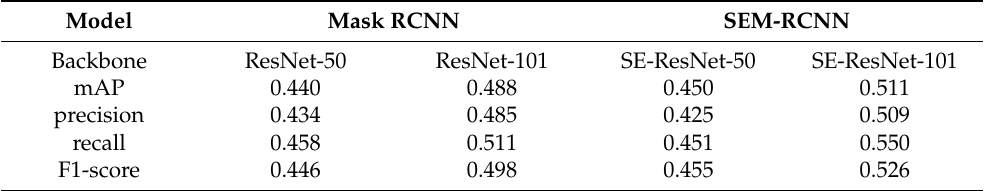
Table 3. The average detection indices (with 5-fold cross validation) of SEM-RCNN and Mask RCNN.